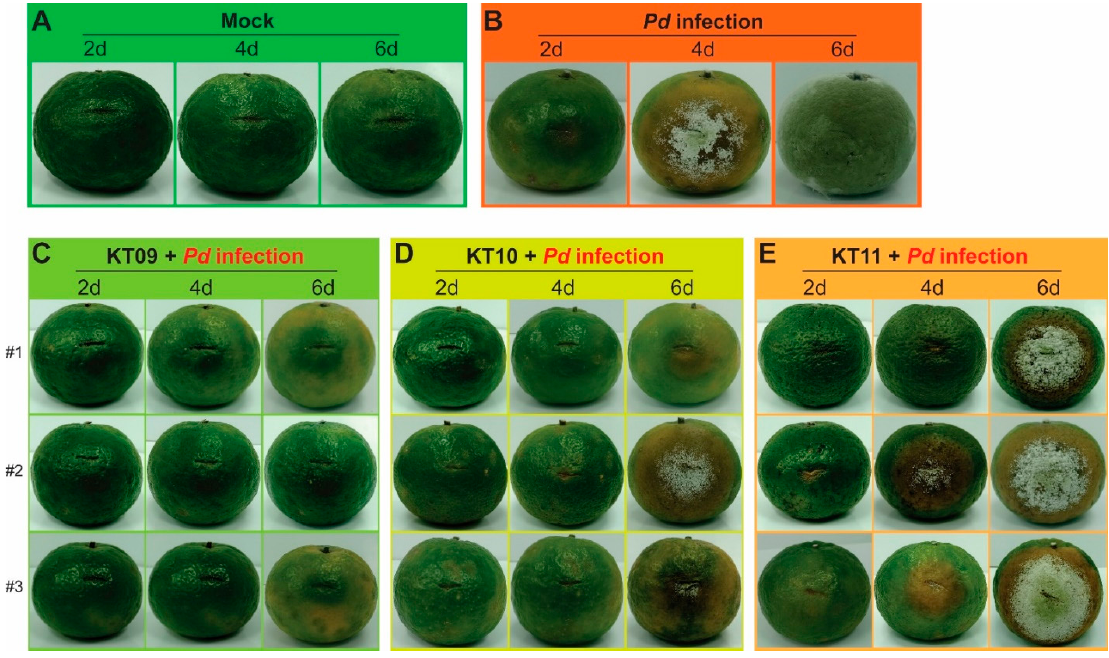
Figure 3. Effect of three selected plant extracts against the postharvest pathogen P. digitatum ( Pd ) on orange fruits. The wounded oranges treated with sterile water were used as negative, mock-infected control ( A ), and infected but untreated fruits acted as the positive control ( B ). The wounded fruits were soaked in a solution containing 800 µg/mL of the KT09 ethanolic extract ( C ), 300 µg/mL of the KT10 water extract ( D ), or 1000 µg/mL of the KT11 ethanolic extract ( E ) before infection with P. digitatum spores. Experiments were conducted in triplicate. The treated fruits were incubated in sterile plastic boxes at 25 °C for 2–6 days. Three different fruits (#1, #2, and #3) were used as examples for each extract treatment.